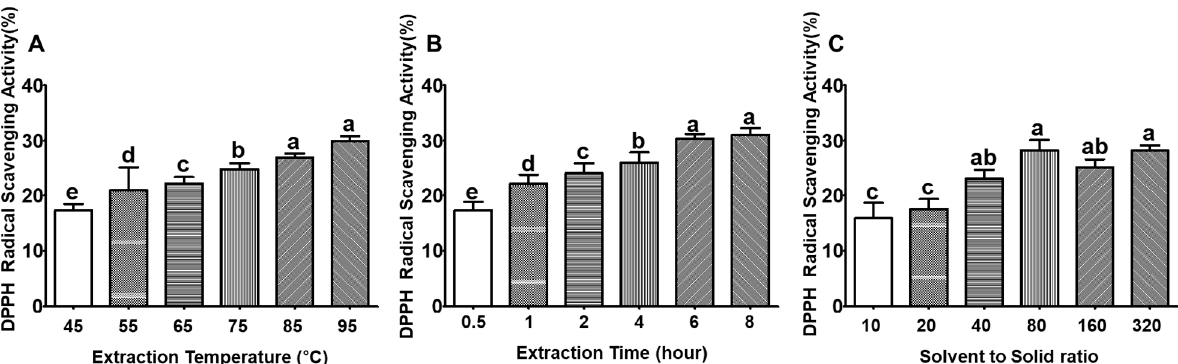
Figure 2. Measurement of the DPPH (2,2-diphenyl-1-pictylhydrazyl) activity by changing the extraction time, the extraction temperature, and the solvent-to-solid ratio for hydrothermal extraction of Acer tegmentosum. ( A ) Extraction temperature varied from 45–95 °C, and extraction time and solvent-to-solid ratio were fixed at 2 h and 80, respectively. ( B ) Extraction time varied from 0.5–8 h, and extraction temperature and solvent-to-solid ratio were fixed at 85 °C and 80, respectively. ( C ) Solvent-to-solid ratio varied from 10–320, and extraction temperature and extraction time were fixed at 85 °C and 2 h, respectively. Data are presented as the mean ± standard deviation ( n = 3). Labeled averages without a common letter differ. p < 0.05.